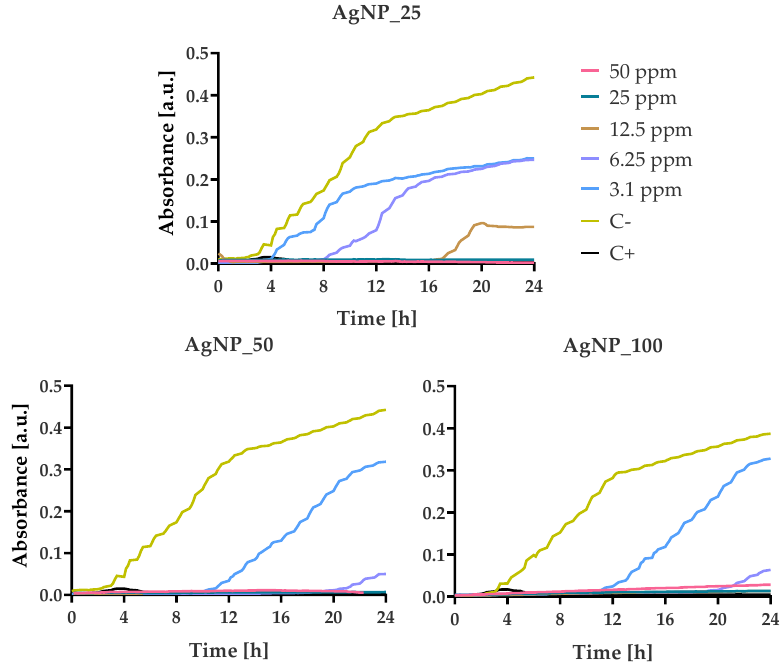
Figure 6. Growth kinetics of E. coli in the presence of different concentrations (from 3.125 to 50 ppm) of AgNPs. Optical density was measured for 24 h at 37 °C using a multi-detection microplate reader at 600 nm and automatically recorded for each well every 15 min. In all experiments, the bacterial suspension in pure MH-B and in the presence of amoxicillin/clavulanic acid (50 ppm) were taken as negative and positive control, respectively. For the growth kinetic experiments of P. aeruginosa , streptomycin (100 μg/mL) was used as positive control due to its resistance in amoxicillin/clavulanic acid. For all treat- ments, P. aeruginosa cells presented a growth kinetics delay of 6 h in the presence of 3.1 ppm of AgNPs samples in comparison with the untreated control C- (Figure 7). After 12 h of incubation, there was an increase in growth at 6.25 ppm of the AgNP_50 sample.